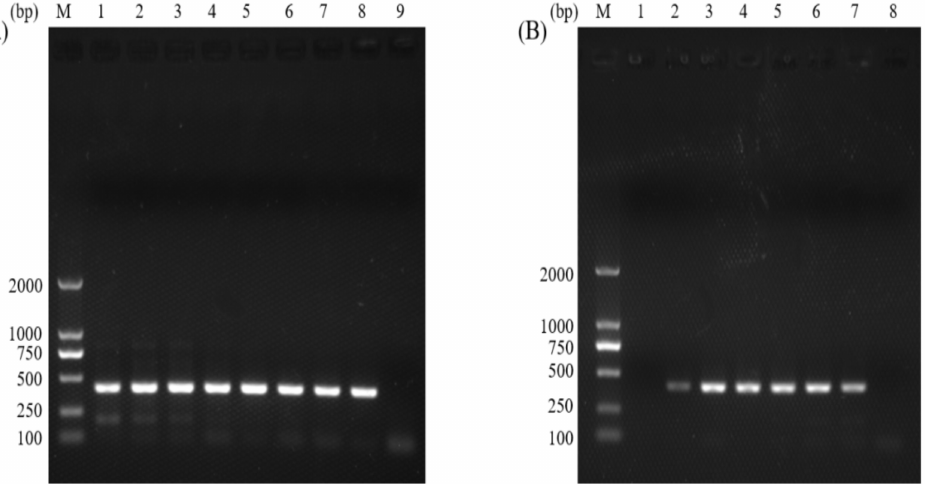
Figure 1. Optimization of the annealing temperature ( A ) and the concentration of MgCl 2 ( B ) of the normal PCR assay. ( A ) lane M: DL2000 DNA Marker (TakaRa); lane 1: 50 ◦ C; lane 2: 50.5 ◦ C; lane 3: 52 ◦ C; lane 4: 54 ◦ C; lane 5: 56 ◦ C; lane 6: 58 ◦ C; lane 7: 59.5 ◦ C; lane 8: 60 ◦ C; lane 9: negative control. ( B ) lane M: DL2000 DNA Marker (TakaRa); lane 1: 0.42 mM; lane 2: 0.83 mM; lane 3: 1.25 mM; lane 4: 1.67 mM; lane 5: 2.08 mM; lane 6: 2.5 mM; lane 7: 2.92 mM; lane 8: negative control.